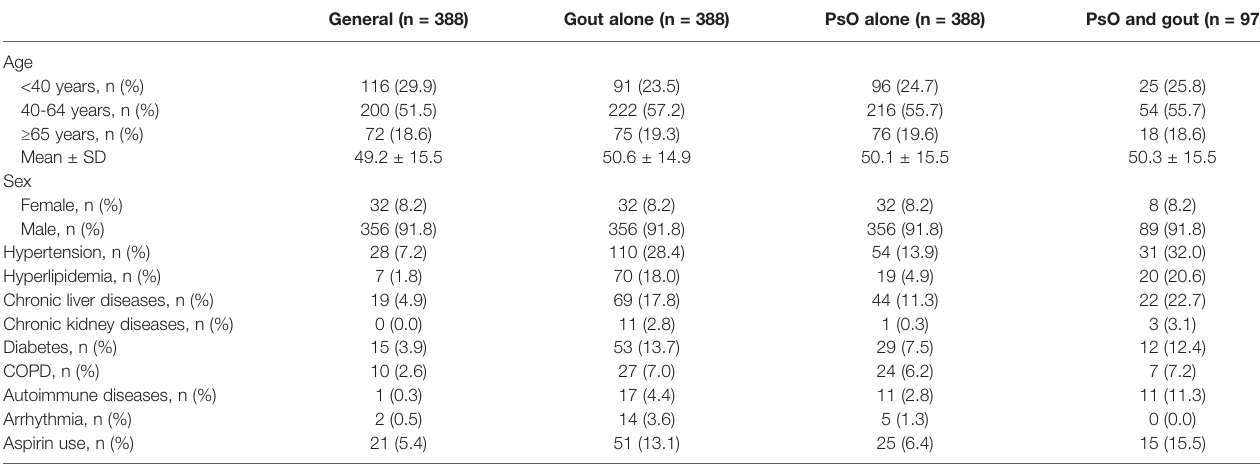
TABLE 1 | Baseline characteristics of the study population according to the history of psoriasis and